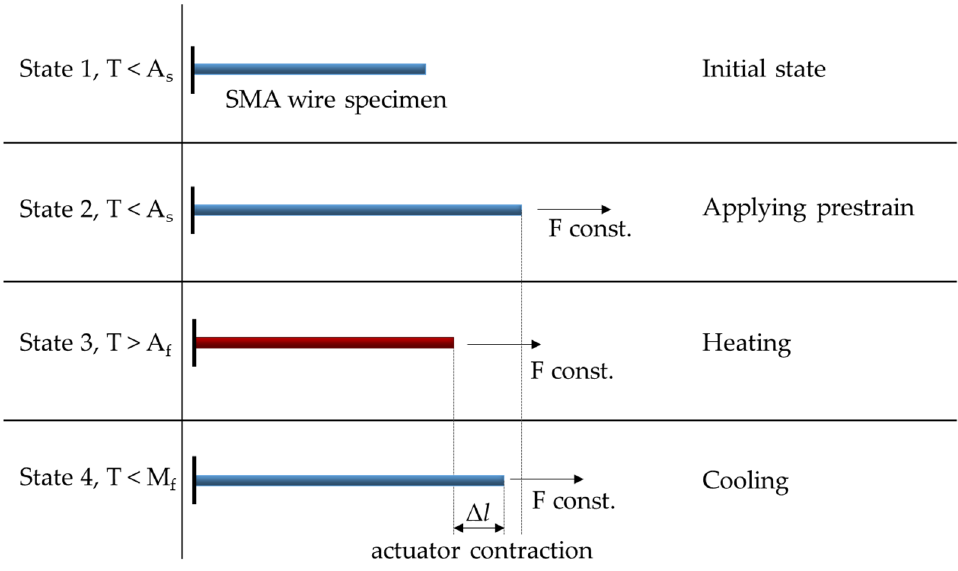
Figure 1. Basic principle of the one-way shape memory effect.